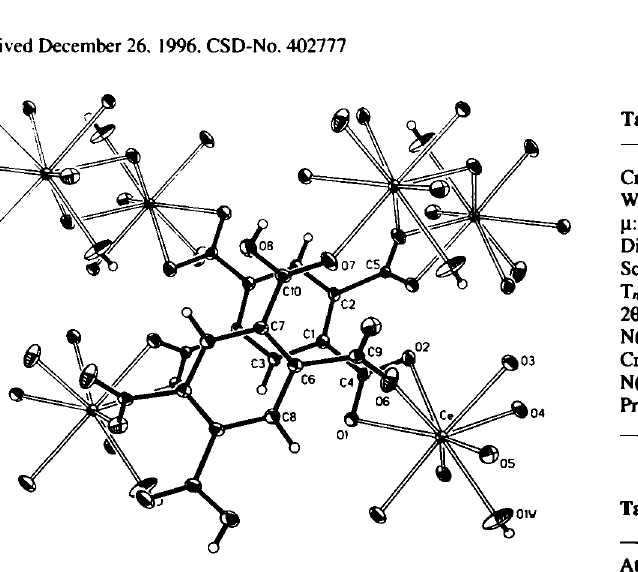
Table 2. Final atomic coordinates and displacement parameters (in Â 2